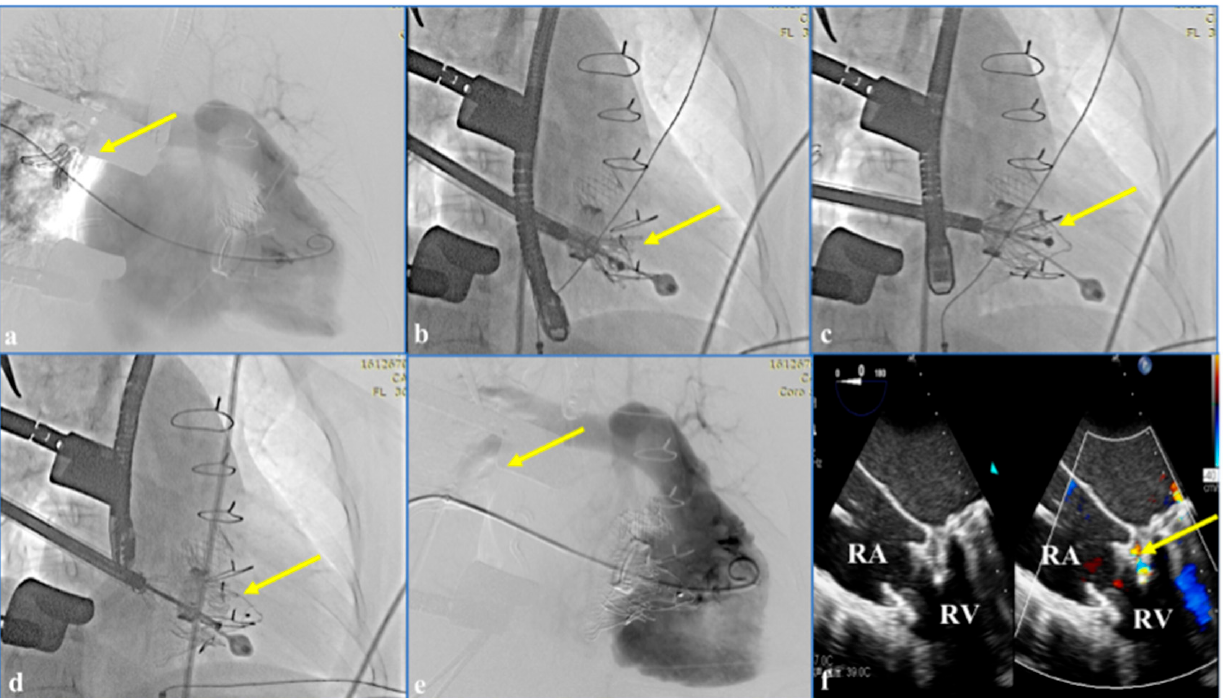
Figure 4. Intra- and postprocedural digital subtraction angiography and transesophageal echocar- diography images showing the procedures. ( a ) Computed tomography angiography before the procedure showed massive regurgitation in the tricuspid valve; the arrow indicates the regurgitation. ( b ) The right atrium was incised and the delivery system was delivered into the right ventricle; the arrow points to the delivery system. ( c ) The anchor pin was positioned in the septum; the arrow points to the anchor pin. ( d ) The delivery system was separated from the tricuspid valve and with- drawn from the right atrium; the arrow points to the delivery system. ( e ) Computed tomography angiography shows no significant regurgitation; the arrow points to the tricuspid valve. ( f ) Transesophageal echocardiography displayed only mild TR; the arrow indicates the TR. Chinese words are temperature. RA: right atrium; RV: right ventricle.